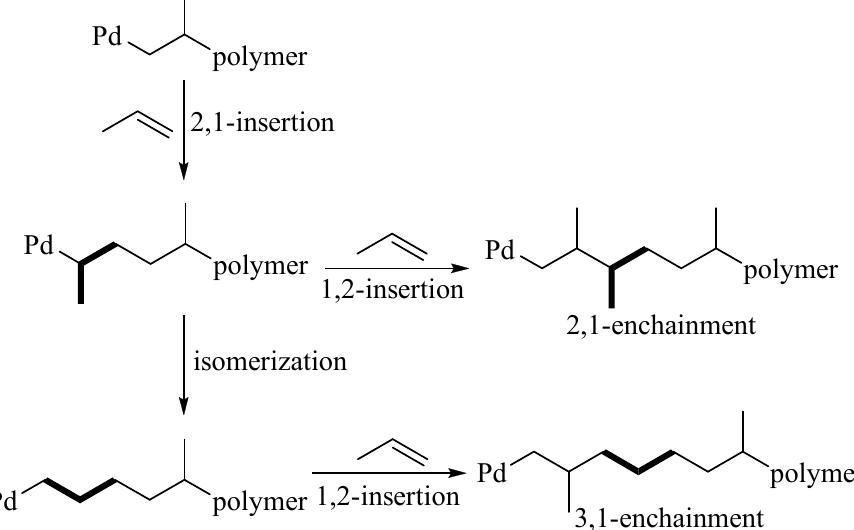
Figure 2. The general mechanism of propylene chain walking polymerization with iminopyridyl Pd(II) catalysts.